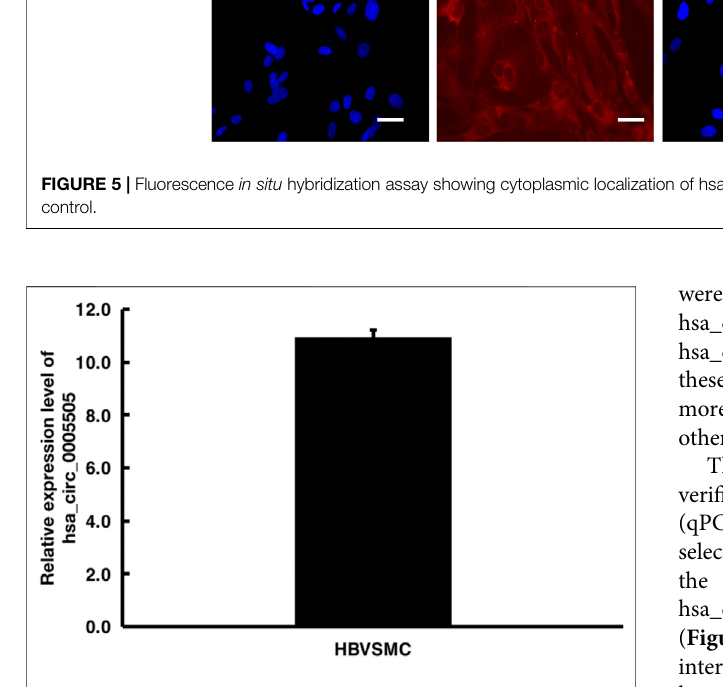
FIGURE 6 | Quantitative real-time PCR analysis of hsa_circ_0005505 expression level in HBVSMCs. GAPDH was regarded as the reference gene. △ Ct value (cid:1) Ct value of target gene - Ct value of reference gene. △ Ct value ≤ 12 representsthe high expression oftarget gene in cells, △ Ct value ≥ 16 represents the low expression of target gene in